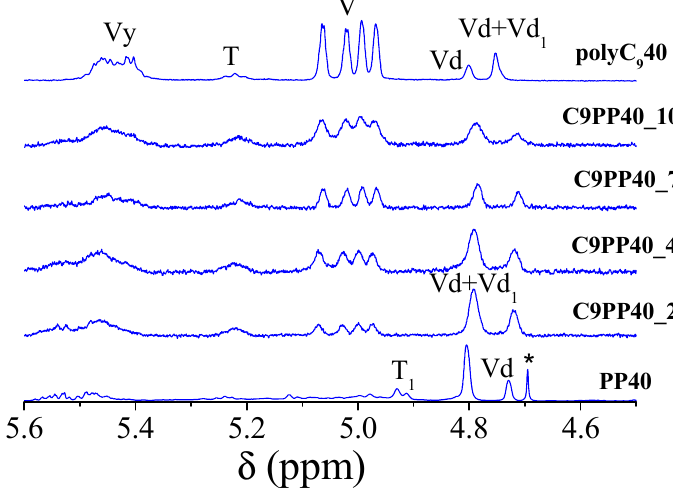
Figure 2. Olefinic window of 1 H NMR spectra for samples obtained at 40 °C. (* solvent impurity).